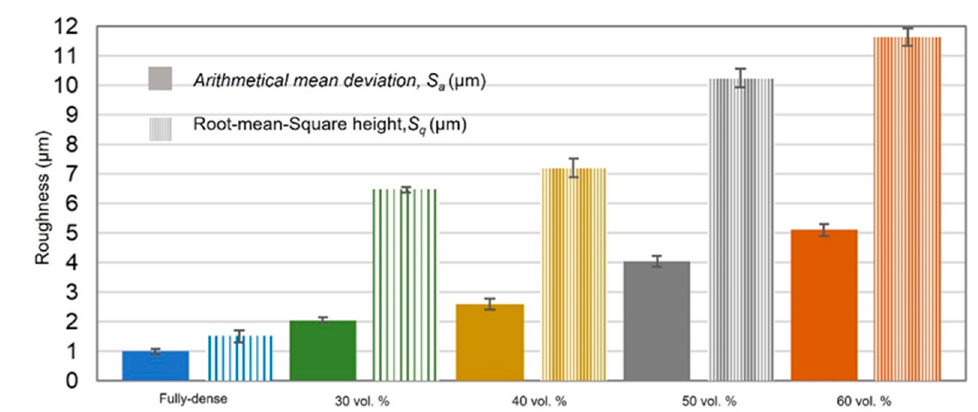
Figure 5. Sa and S q values measured from the CLM images for all the studied c.p. Ti substrates (fully- dense and 100–200 μ m for porous substrates).